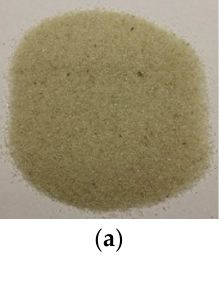
Figure 1. Candidate particulate materials: ( a ) Riyadh white sand; ( b ) Riyadh red sand; ( c ) ilmenite; ( d ) Carbobead CP.